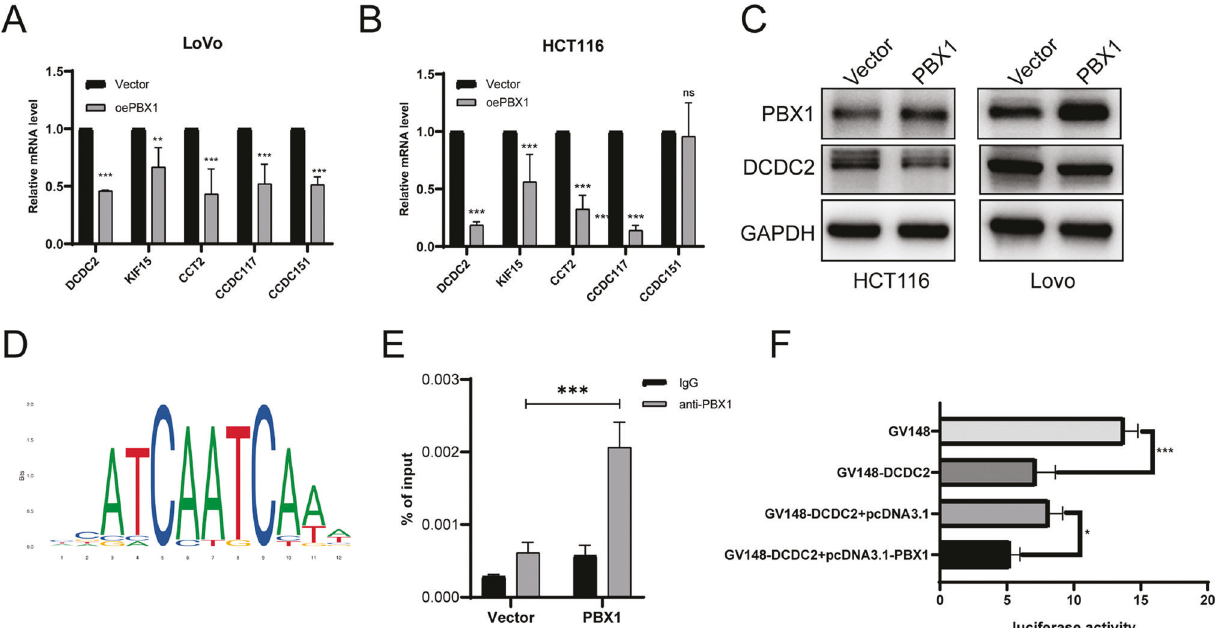
Fig. 5 PBX1 transcriptionally suppressed DCDC2 expression in CRC. A , B RT-qPCR detected the mRNA levels of fi ve potential downstream genes under PBX1 overexpression. C Western blotting assay suggested DCDC2 protein levels were decreased under PBX1 overexpression. D The predictive sequence of the PBX1-binding site from JASPR database. E ChIP-qPCR assay with anti-PBX1 and negative IgG showed that anti-PBX1 enriched the DCDC2 regulator region. F The regulator region of DCDC2 was synthesized for the luciferase reporter assay. This region signi fi cantly decreased luciferase activity, while PBX1 enhanced this